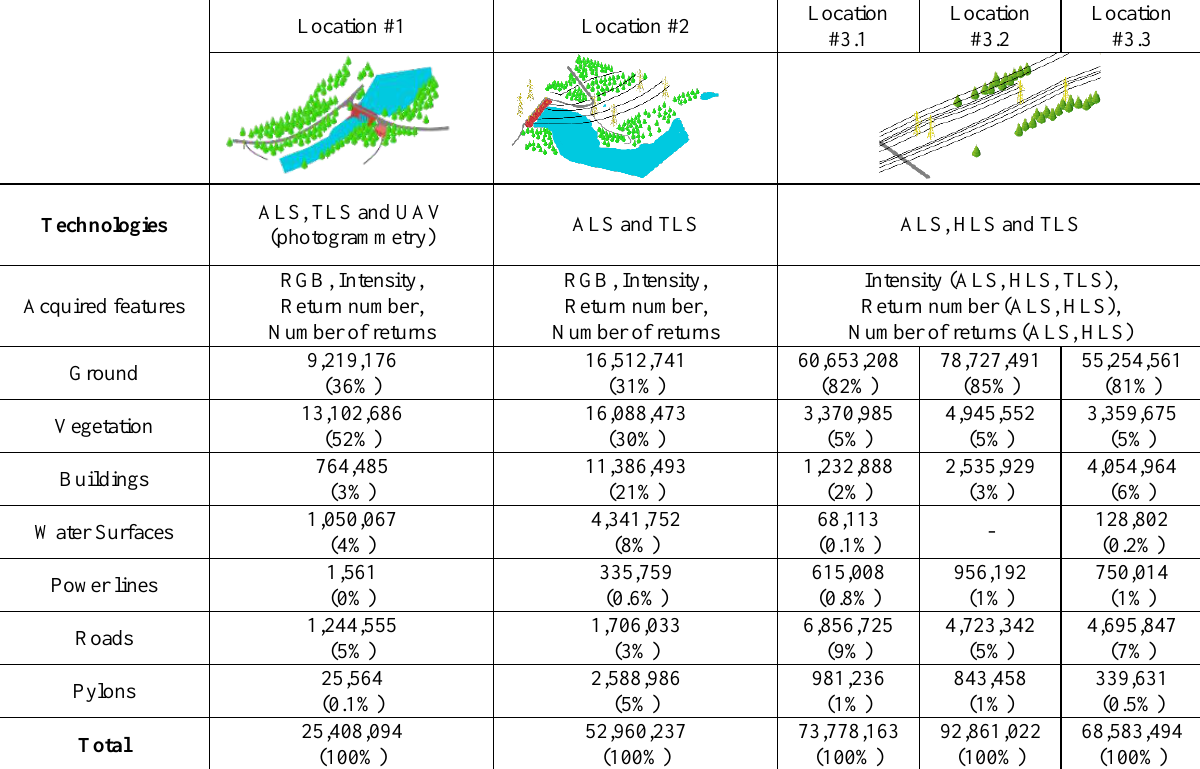
Table 2. Point cloud representations with their classes and acquired